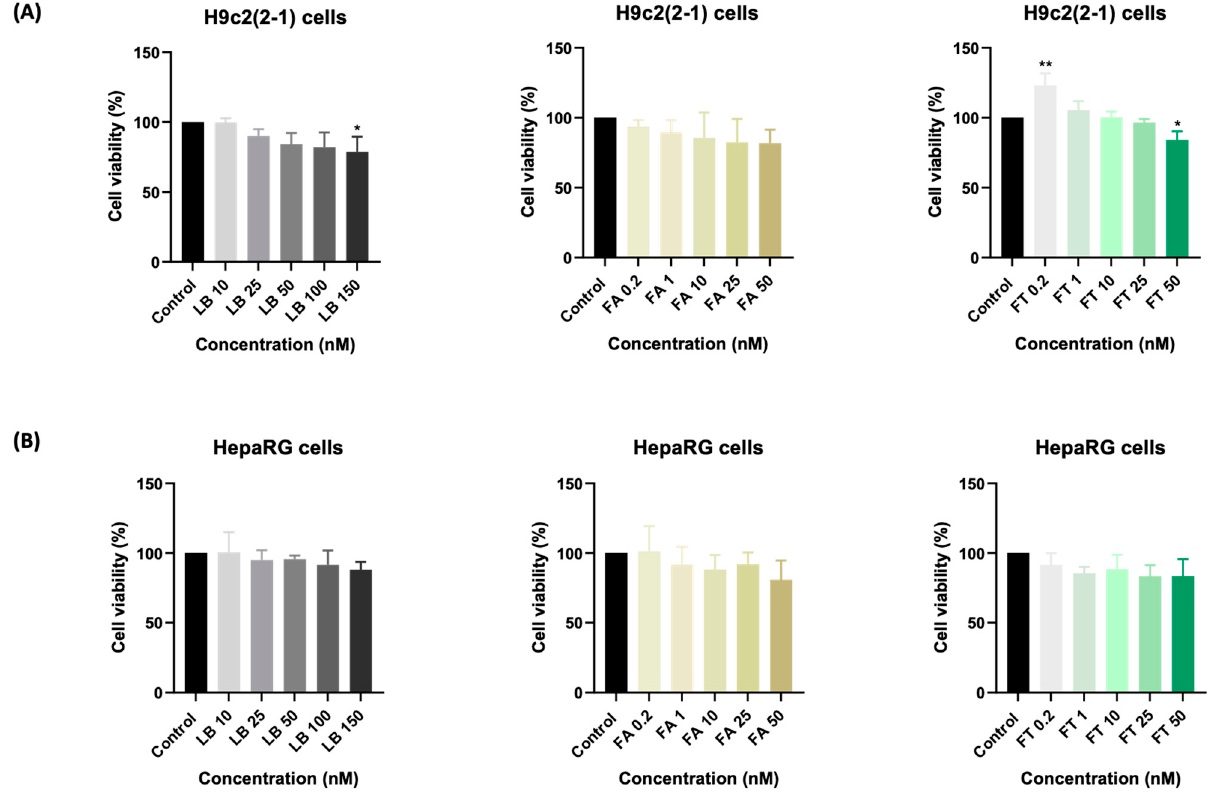
Figure 1. The impact of a 72-h treatment with labetalol (LB), folic acid (FA), and folate (FT) on the viability of ( A ) H9c2(2-1) and ( B ) HepaRG cells. The data are expressed as the mean values ± SD of three independent experiments performed in triplicate ( n = 3). The statistical differences between the control and the treated group were quantified by one-way ANOVA analysis followed by Dunnett’s multiple comparisons post-test (* p < 0.05; ** p <